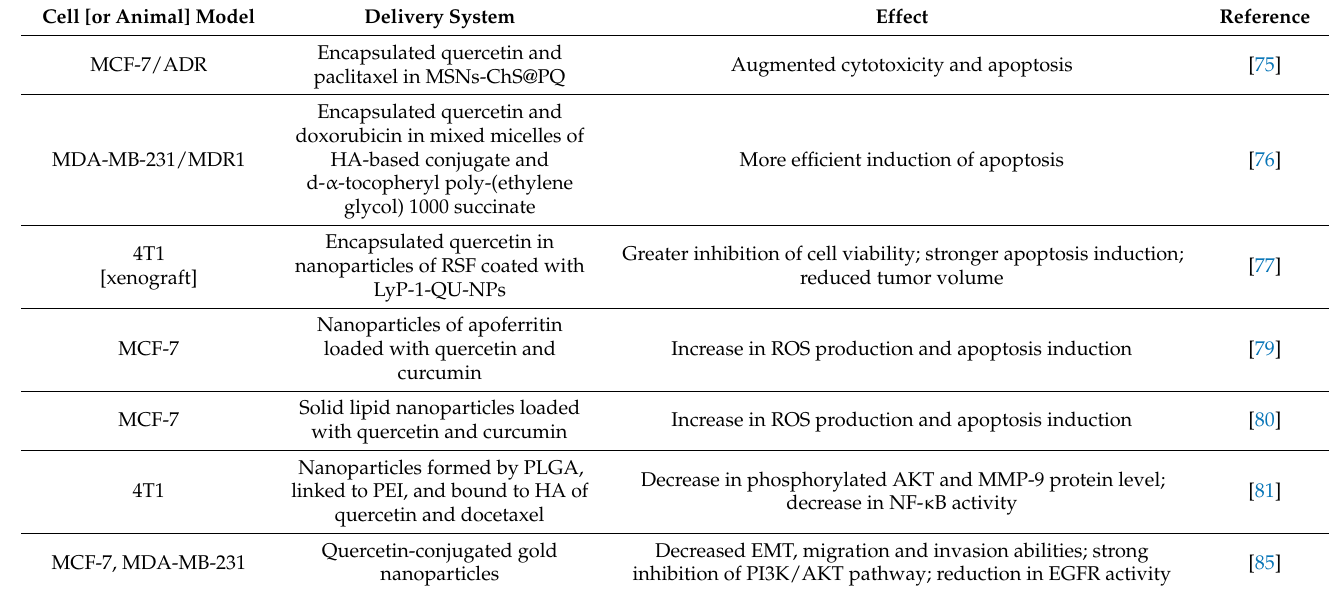
Table 3. Targets affected by quercetin in different delivery systems in BC experimental